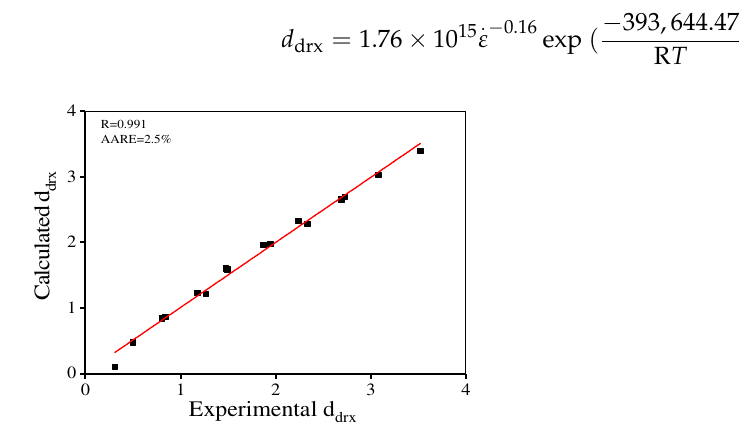
Figure 18. Comparisons between the calculated and experimental d drx .